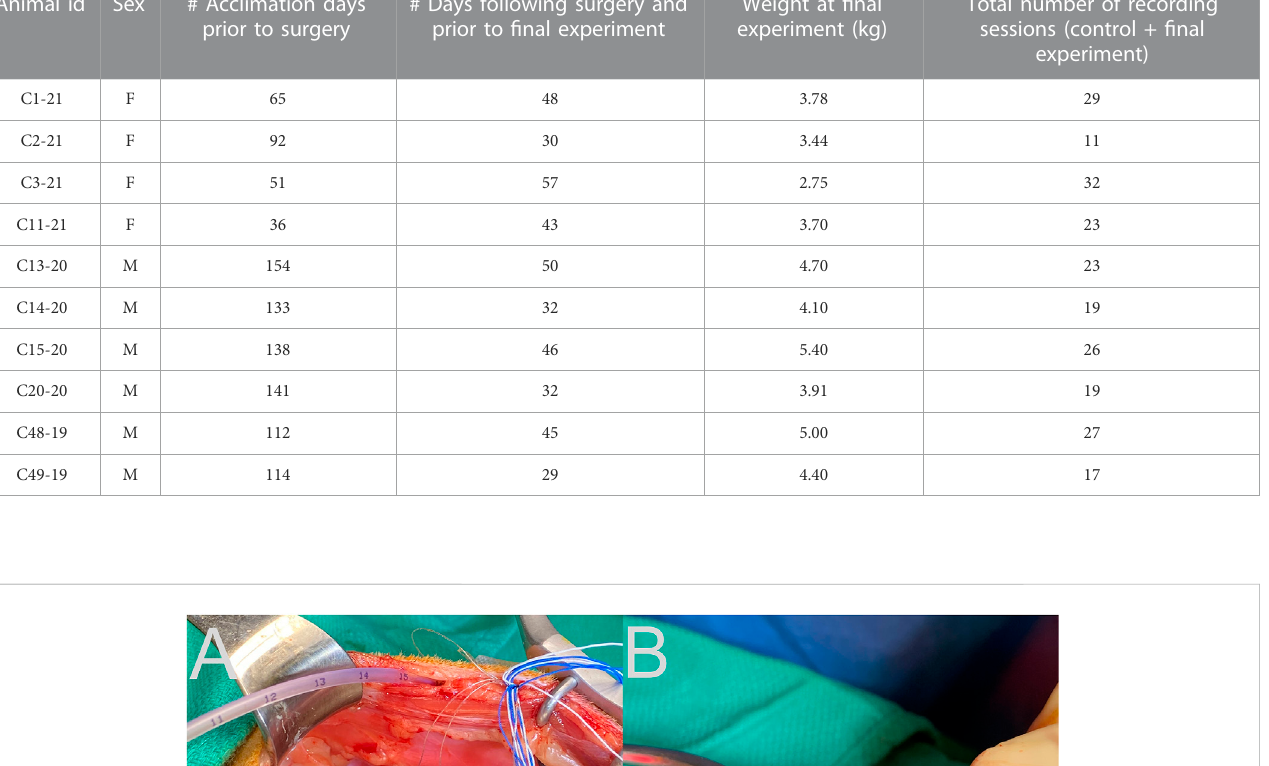
TABLE 1 Characteristics of animals used in the experiments, as well as experimental parameters. Animal id